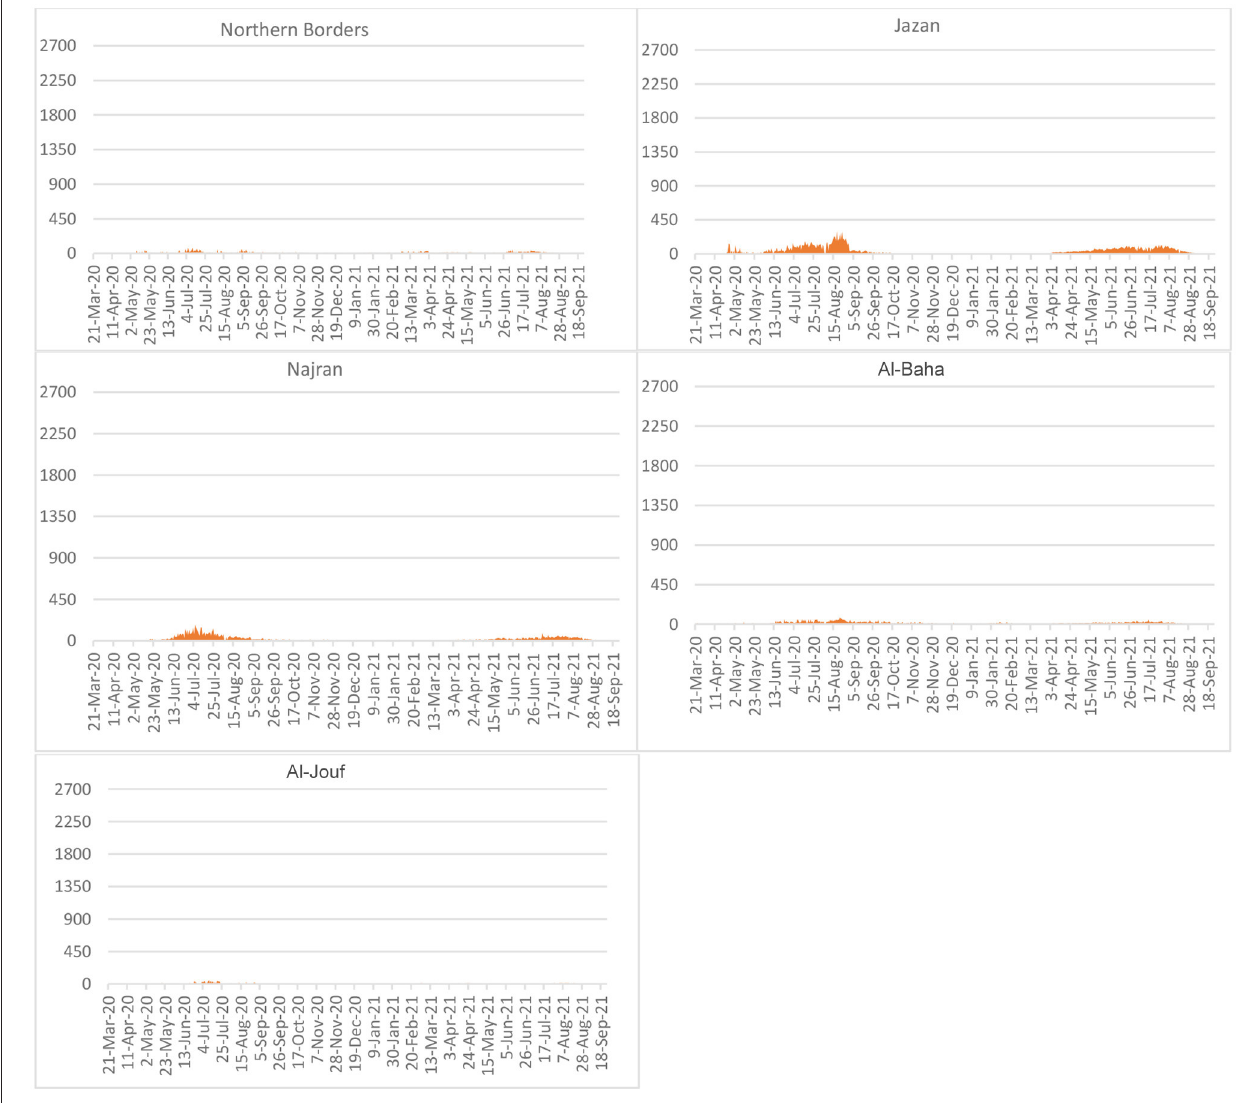
FIGURE 4 | Spatial distribution of infections reported